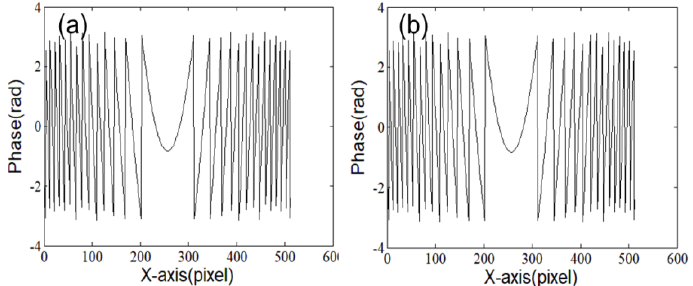
Figure 4. Phase distribution across the center of the zones of the object wave, ( a ) original phase distribution and ( b ) reconstructed phase distribution.